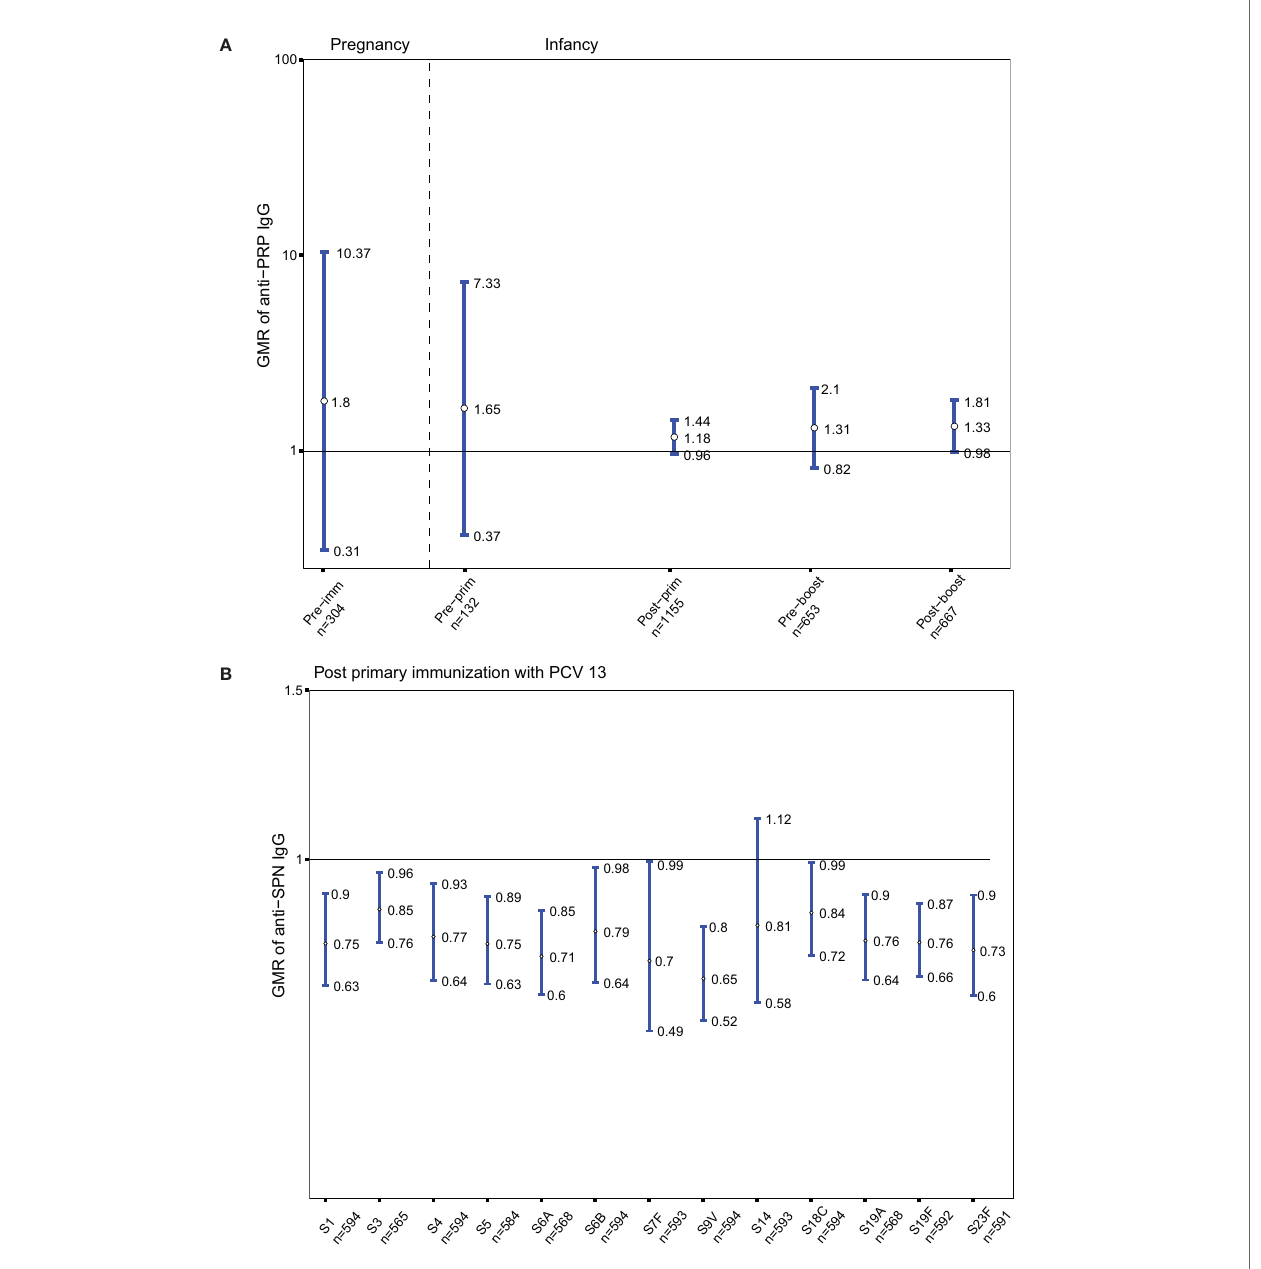
FIGURE 4 | (A) Antibody responses to Haemophilus in fl uenza type b (polyribosylribitol phosphate [PRP]). Geometric mean ratio (GMR) of anti-PRP IgG levels in women immunized with tetanus-diphtheria-acellular-pertussis (Tdap) versus women who did not receive Tdap or diphtheria and tetanus toxoids (dT) or TT vaccine in pregnancy pre-immunization; in infants born to women immunized Tdap versus infants of women not immunized with Tdap, dT, or TT vaccine in pregnancy pre- primary, post-primary, pre-booster and post-booster immunization with diphtheria-tetanus-acellular-pertussis-Hib vaccine. (B) Antibody responses to Streptococcus pneumoniae (SPN). GMR of anti-SPN IgG levels in infants born to women immunized with Tdap compared with infants of women who did not receive Tdap or dT vaccine in pregnancy after their primary immunization with pneumococcal conjugate vaccine 13 (PCV 13). Vertical blue lines indicate the GMR with the 95% con fi dence interval. Horizontal black line indicates a GMR of 1. The numbers available for meta-analysis are indicated (n). GMR results displayed are derived from mixed-effects models. Pre-imm, pre-immunization; Pre-prim, pre-primary; Post-prim, post-primary; Pre-boost, pre-booster; Post-boost, post-booster; S,